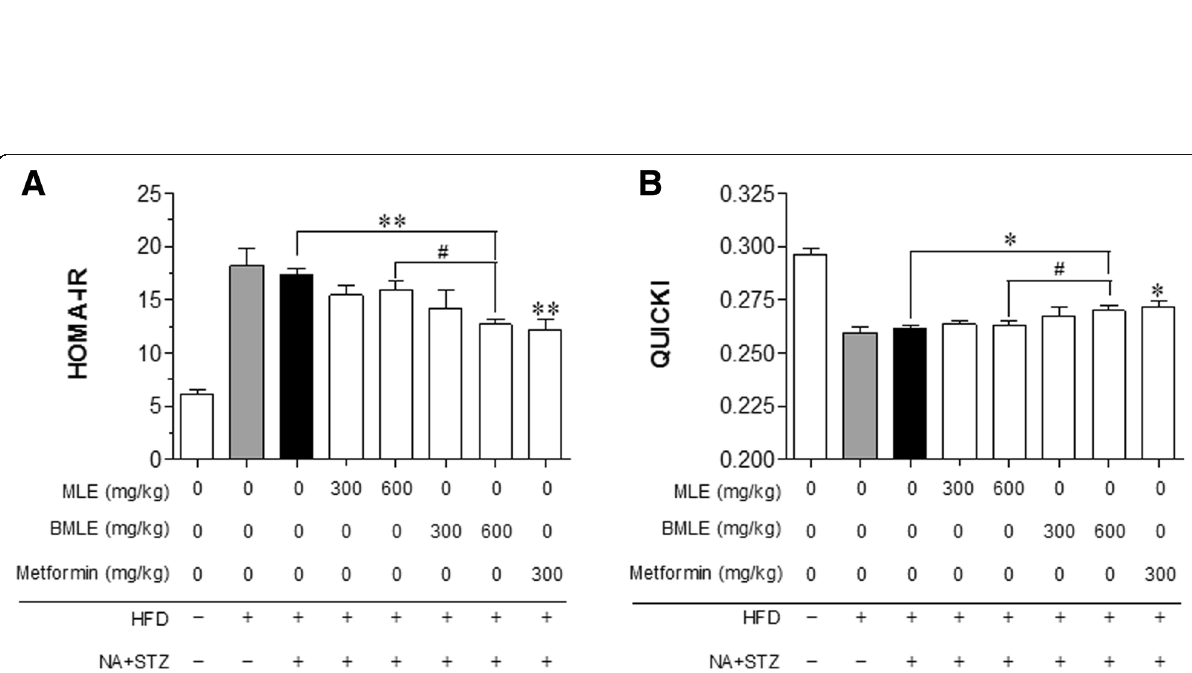
Fig. 7 Effects of bioconverted mulberry leaf extract (BMLE) and unaltered mulberry leaf extract (MLE) on indices of insulin resistance and insulin sensitivity in obese diabetic mice. MLE (300 and 600 mg/kg) or BMLE (300 and 600 mg/kg) were administered (PO) for 7 weeks in obese diabetic mice, and ( a ) homeostasis model assessment of insulin resistance (HOMA-IR) and ( b ) quantitative insulin sensitivity check index (QUICKI) values were calculated by measuring fasting glucose and insulin levels. Data are expressed as the mean ± SEM ( n = 7). * P < 0.05 and ** P < 0.01 versus the vehicle; # P < 0.05 versus the MLE-treated group (600 mg/kg). HFD, high-fat diet; NA, nicotinamide; STZ, streptozotocin